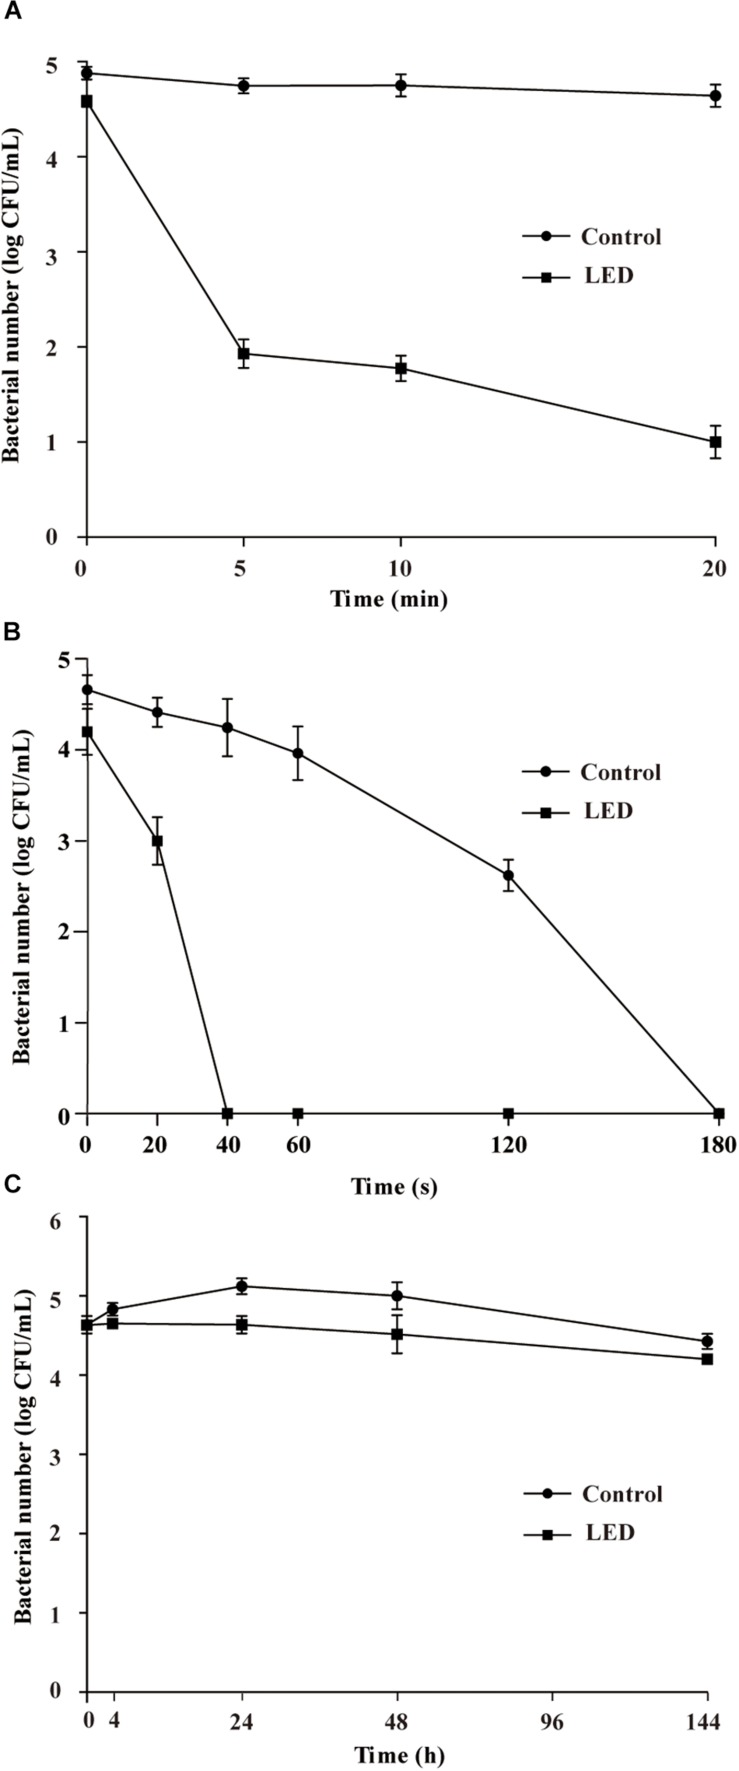
Survival of LED-illuminated and unilluminated L. monocytogenes cultures in 0.04% H2O2
(A), under UV irradiation (B), and at 4°C (C).